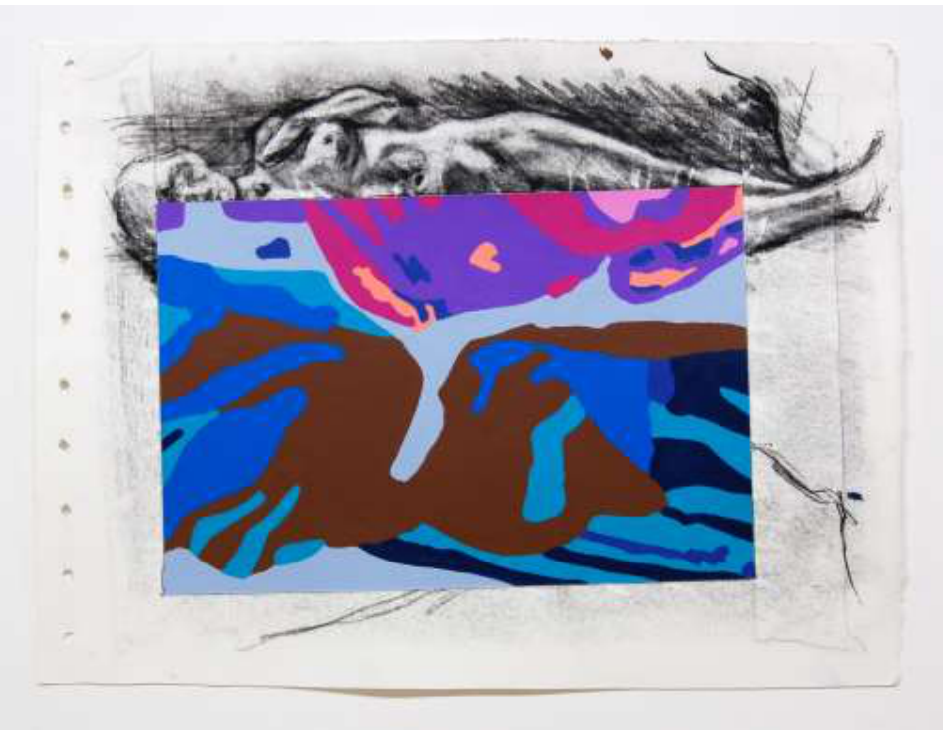
Steven Pearson, Sketchbook Revisions: Plaster Model (Vertical) , 2014, charcoal, graphite, and acrylic on Rives BFK, 12 x 9